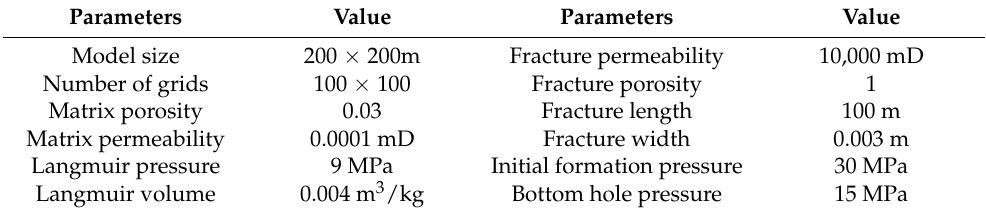
Table 3. Calculated